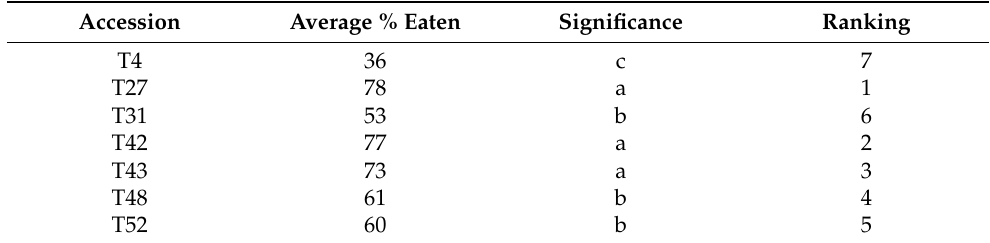
Table 3. Overall preference ranking of all accessions in experiment 1 for the first hour of feeding over six days. Accessions that share no common letters are significantly different ( p < 0.05; LSD 11). Accession Average % Eaten